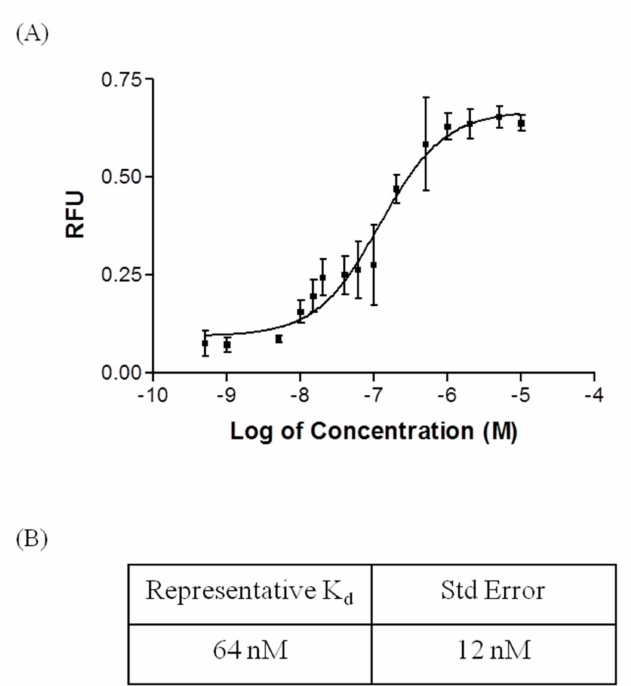
Figure 4. Fluorescent equilibrium binding assay of R12.51. ( A ) Representative saturation binding curve of R12.51 with nonlinear regression sigmoidal curve best fit. Concentration data was transformed by logarithmic scale. Normalized average fluorescence from triplicate samples were presented. Error bars are representative of ± 1 × standard deviations. The goodness of fit ( R 2 ) was 0.87; ( B ) Representative equilibrium dissociation constant with standard error for the presented R12.51 binding assay. Table 2. Cross-reactivity data of R12.51 ssDNA MRE in selection buffer. Target Normalized Average Fluorescence Standard Deviation p -Value Selective Ratio Fipronil